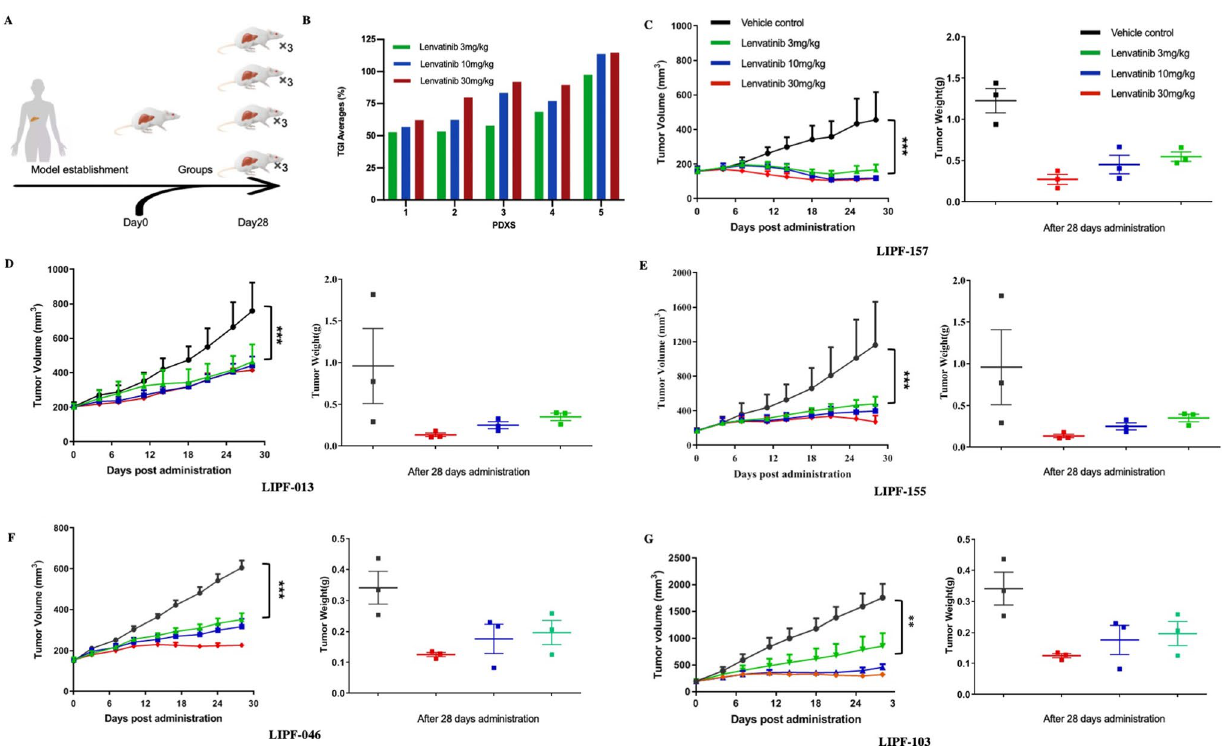
Fig. 1 Lenvatinib exhibits effective antitumor activity in ICC PDX models. a Flow chart of in vivo experiments; b lenvatinib response after treatment in five PDX models; c – g, tumor growth curves and tumor weight box for each PDX case. * P < 0.05, ** P < 0.01, *** P < 0.001, **** P <